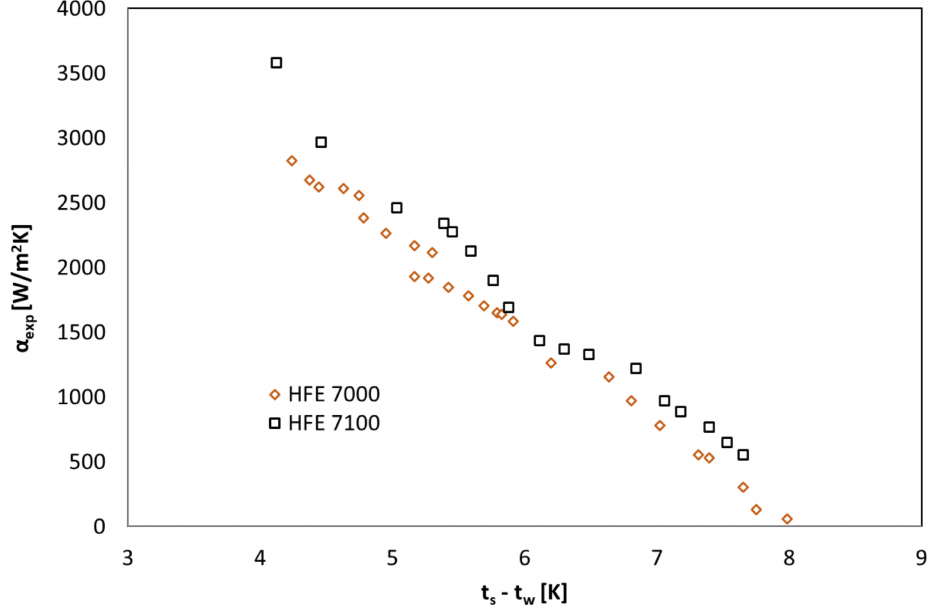
Figure 6. Thermal characteristics of the tested exchanger in the form of the dependence of the heat transfer coefficient on the difference between the saturation temperature and the external wall of the channel temperature α = f(t s − t w ), HFE 7100 and HFE 7000